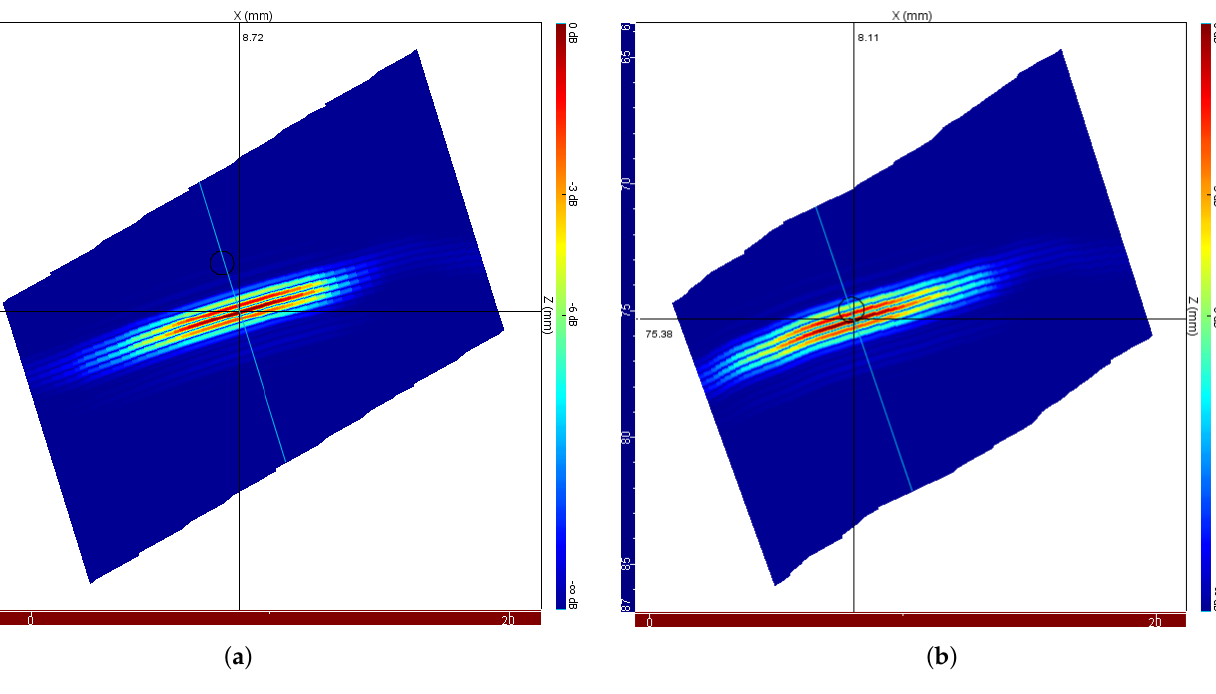
Figure 11. Ultrasonic E-Scan images of the side-drilled hole for the case where the temperature gradients along the sonic path are ( a ) disregarded and ( b ) appropriately treated by applying the proposed focal law correction